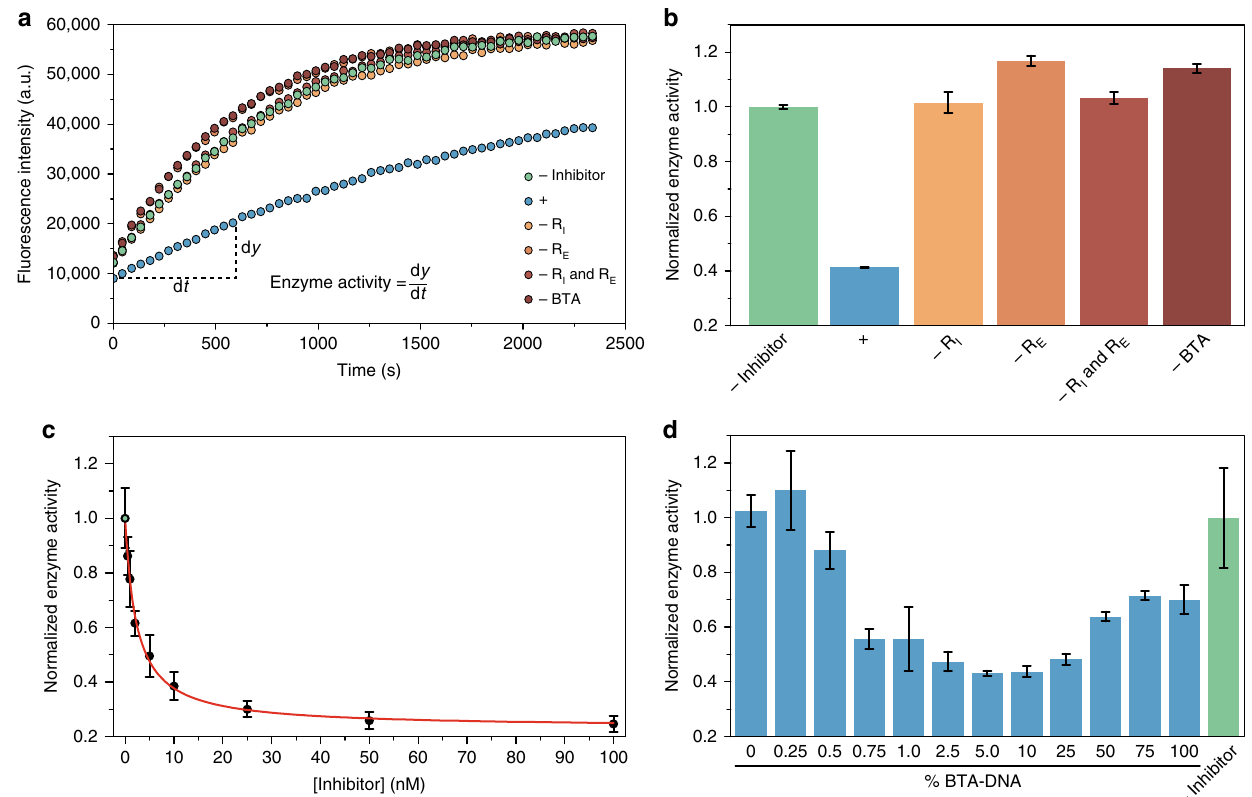
Fig. 3 Characterization of BTA-templated enzyme-inhibitor complex formation. a , b Substrate conversion as a function of time by the recruited enzyme in the absence of BLIP (-inhibitor), the fully assembled system (+) and controls lacking one or both of the recruiter strands (-R I , -R E and -R I and -R E , respectively) or the BTA polymers (-BTA). Turnover of a fl uorescent substrate (CCF2-FA, 2 μ M) was monitored by measuring the fl uorescence intensity at 447 nm. Experiments were performed using 25% BTA-DNA (0.5 μ M BTA-DNA, 1.5 μ M BTA-3OH), 20 nM R E and R I , 1 nM β -lactamase and 10 nM BLIP. Enzyme activities b were obtained from the kinetic traces shown in a by deriving the slope of the initial increase in fl uorescence. Enzyme activities were normalized to a control omitting the inhibitor protein. Error bars represent SEM of duplicate measurements. c Normalized enzyme activity as a function of inhibitor concentration (black dots). The enzymatic activities were fi tted to Eq. 1, which was derived using the Michaelis – Menten model for competitive inhibition, yielding an apparent inhibition constant ( K i,app ) of 2.3 ± 0.2 nM (red line). Experiments were performed using 25% BTA-DNA (0.5 μ M BTA- DNA, 1.5 μ M BTA-3OH), 20 nM R E and 200 nM R I , 1 nM β -lactamase, and 0 – 100 nM BLIP. Error bars represent s.d. calculated from triplicate measurements. d Normalized enzyme activities as a function of BTA-DNA receptor density. Polymers with receptor densities between 100% and 0.25% BTA-DNA were obtained by assembling a fi xed concentration of BTA-DNA (0.5 μ M) with varying concentrations of BTA-3OH (0 – 199.5 μ M). Experiments were performed using 20 nM R E and R I , 1 nM β -lactamase and 10 nM BLIP. Error bars represent s.d. calculated from triplicate